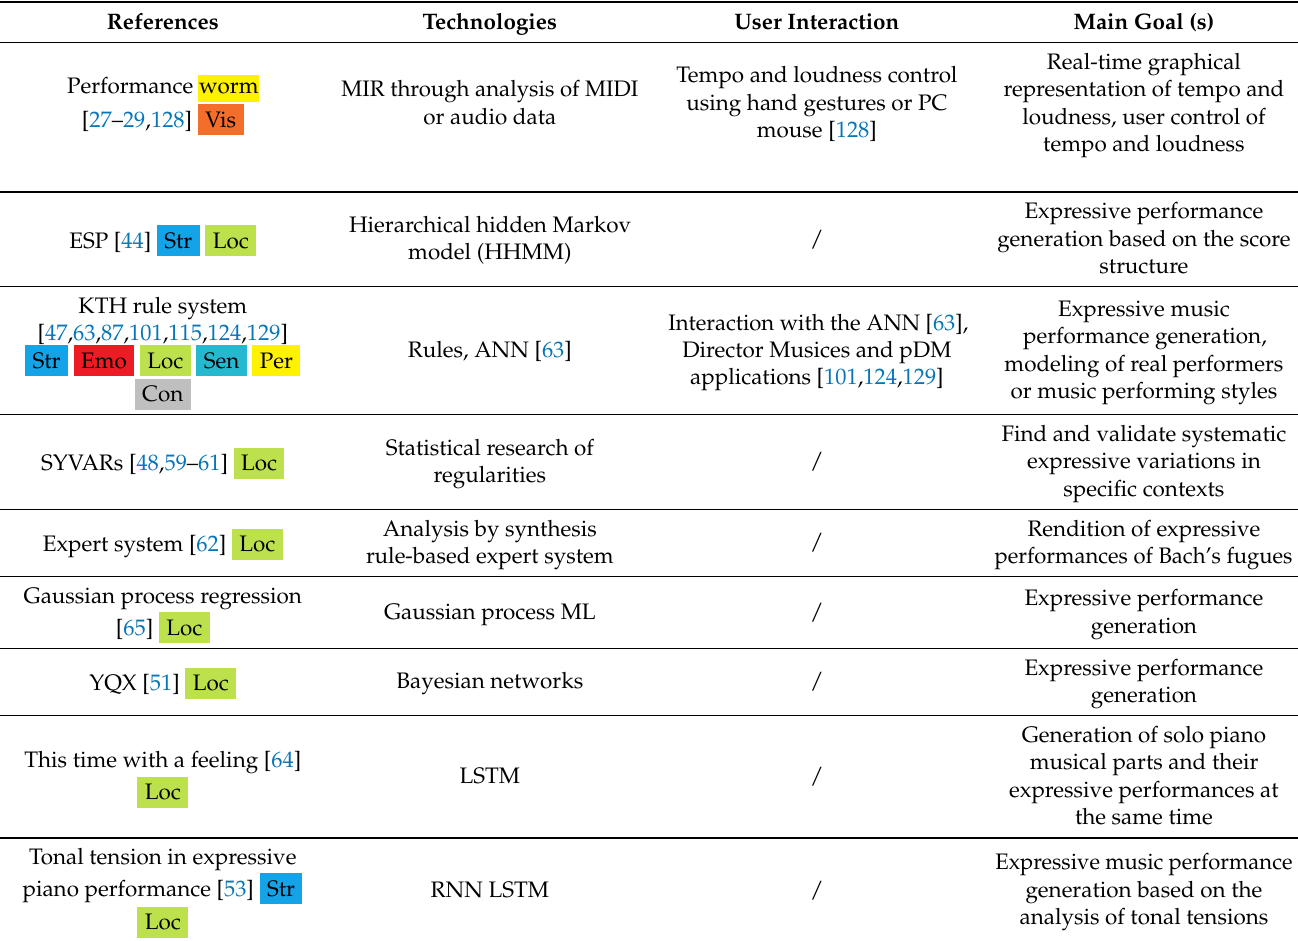
Table 1. Summary